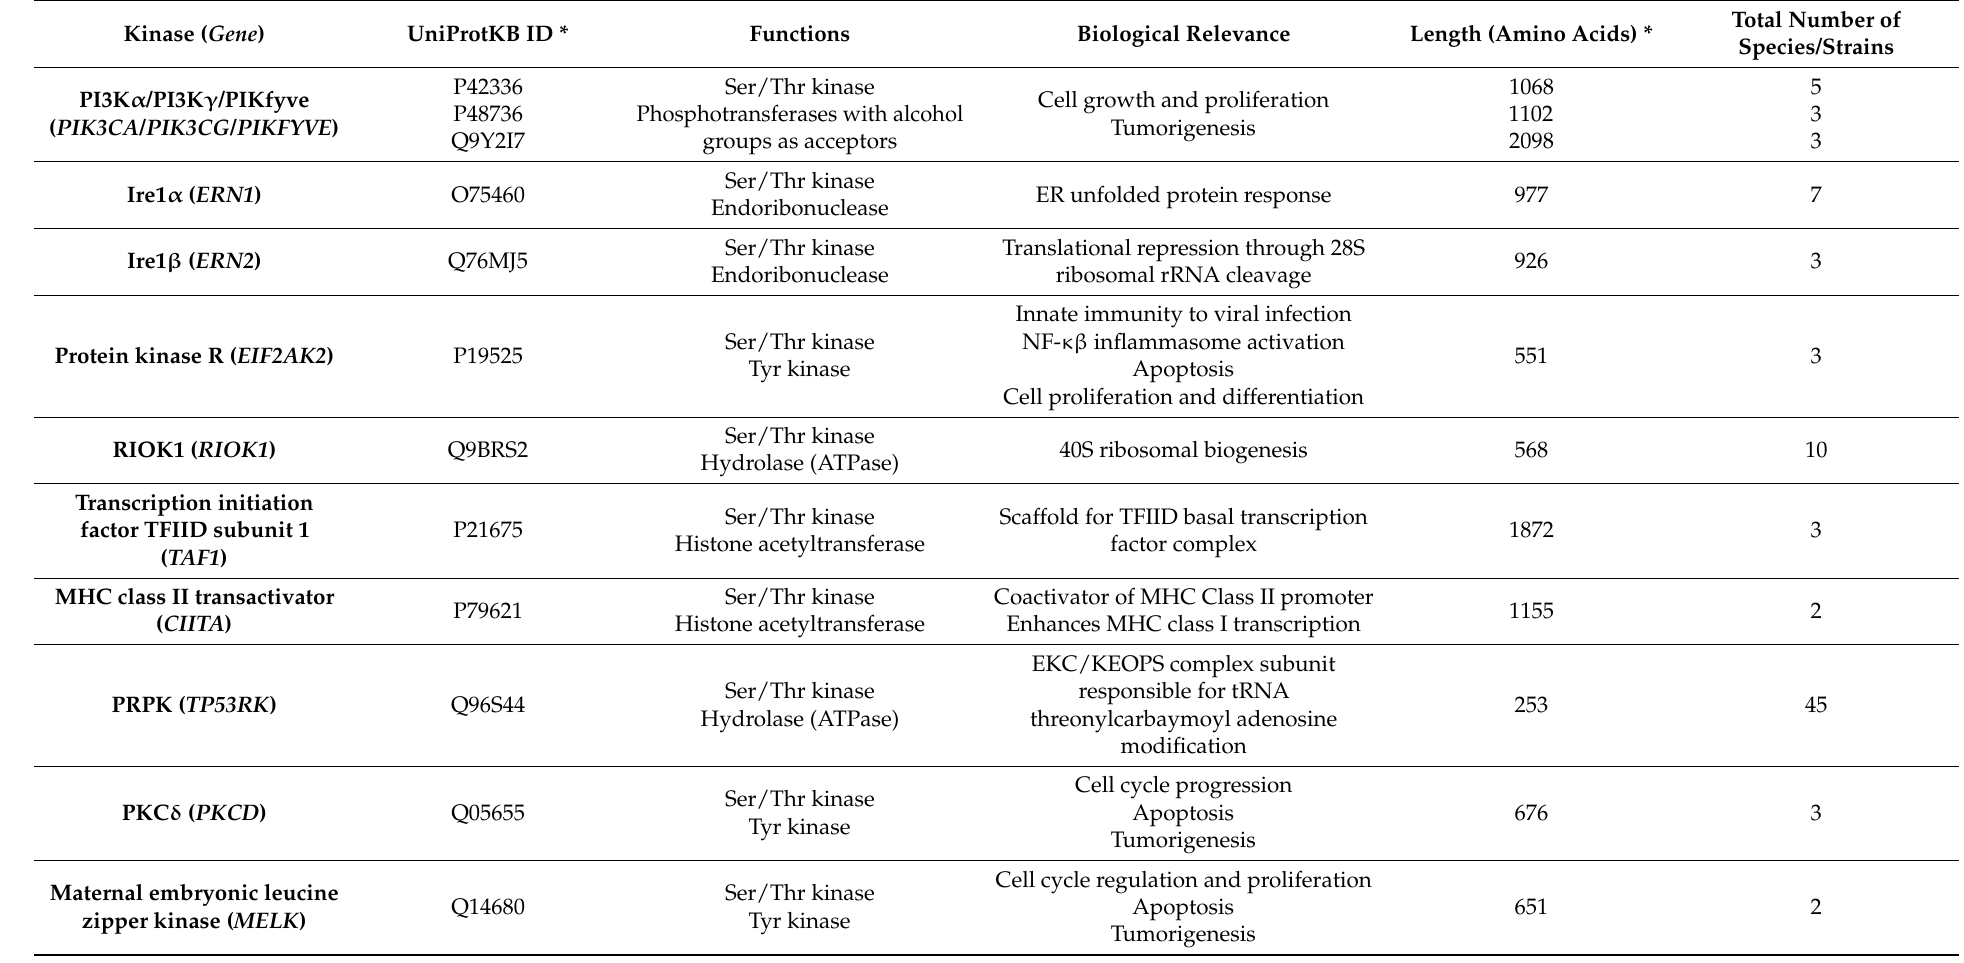
Table 1. Unique bifunctional kinases in the UniProtKB